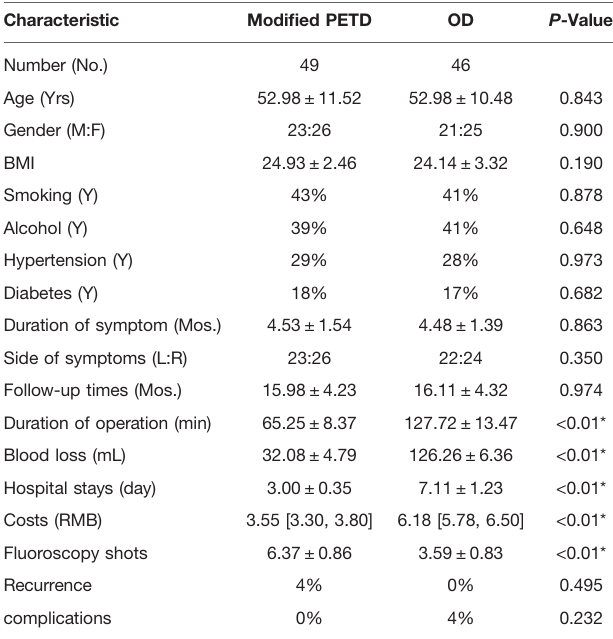
TABLE 1 | Demographic information and Surgical